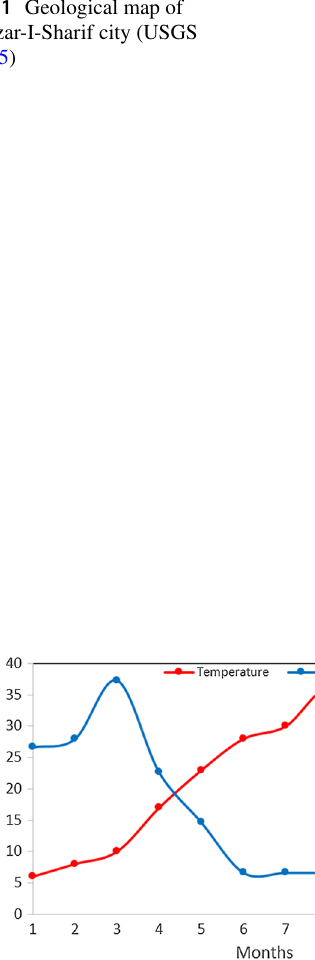
Fig. 1 Geological map of